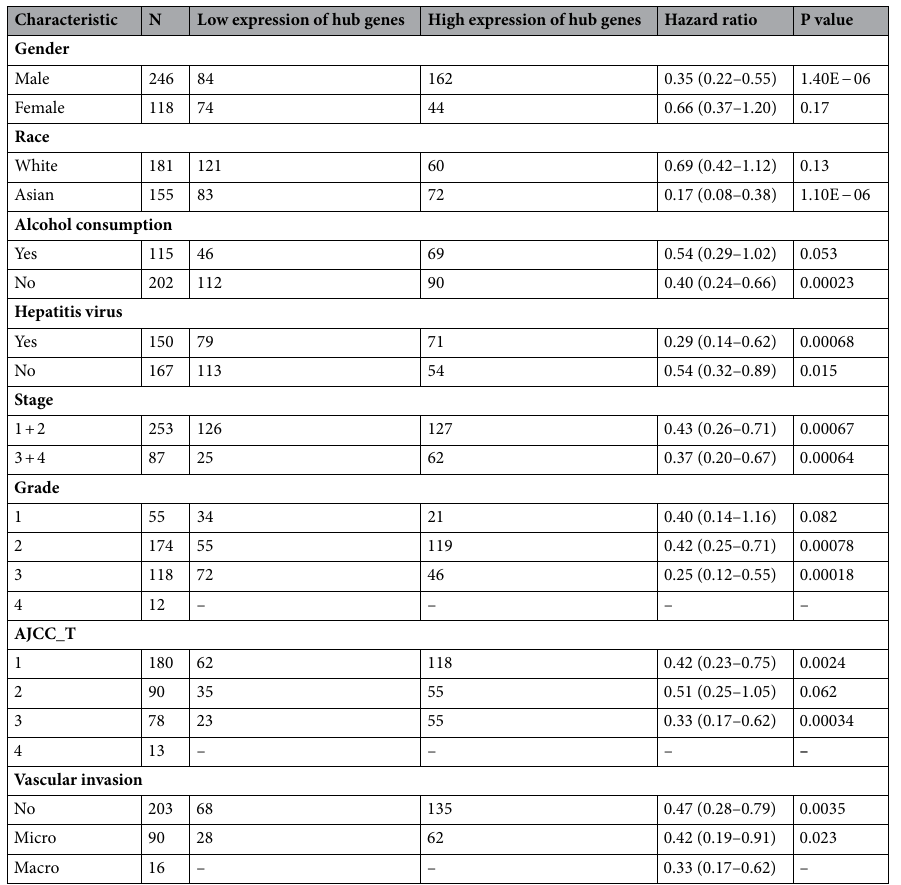
Table 2. Higher combinatory mRNA expressions of all ten hub genes were associated with clinical characteristic in